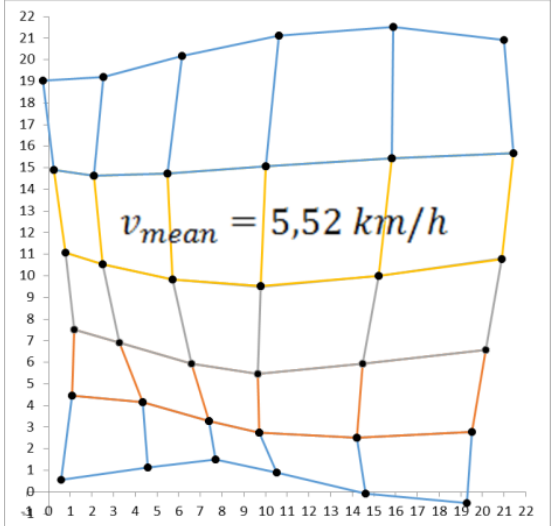
Fig. 5. Anamorphed cross-country rate